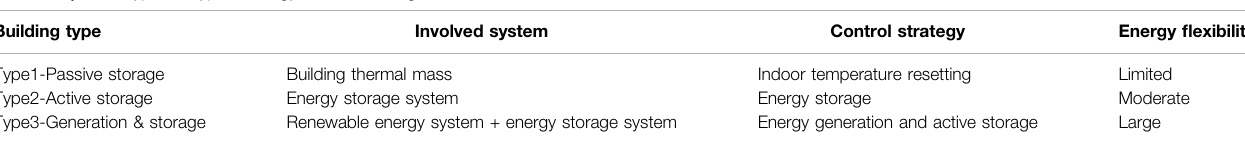
TABLE 1 | Three types of typical energy fl exible